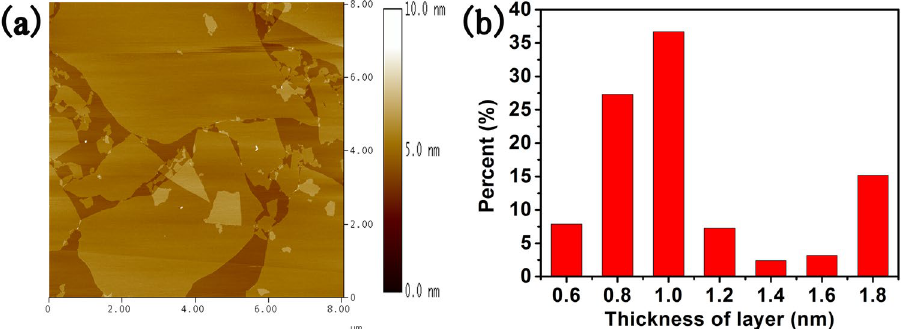
Figure 2. ( a ) AFM image of exfoliated GO sheet. ( b ) Statistical results of GO sheet